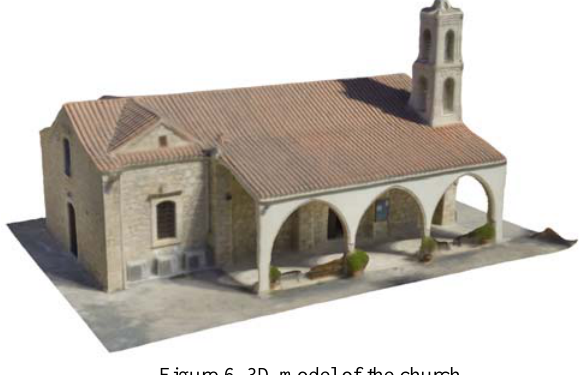
Figure 6. 3D model of the church